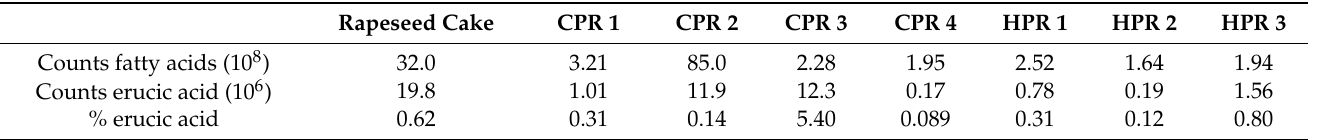
Table 4. Percentage (%) of erucic acid in relation to the total fatty acid content for method E2 +